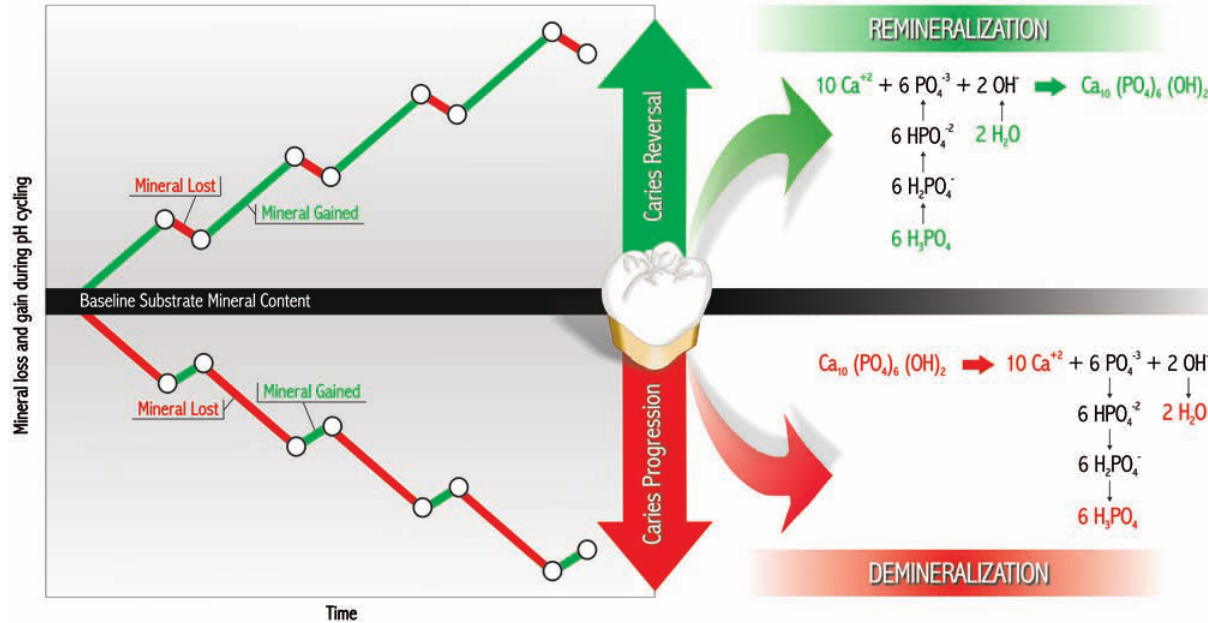
Figure 1- Classification of in vitro pH-cycling models according to the flux of minerals. Modified from White 106